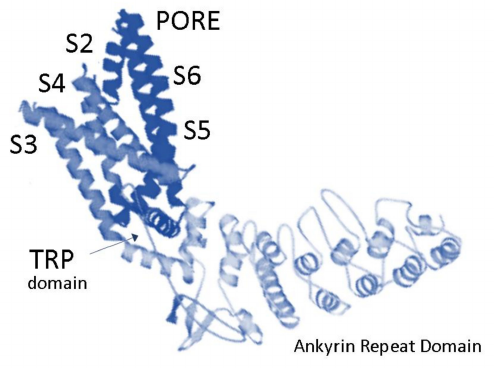
Figure 1. Overview of TRPV2 structural